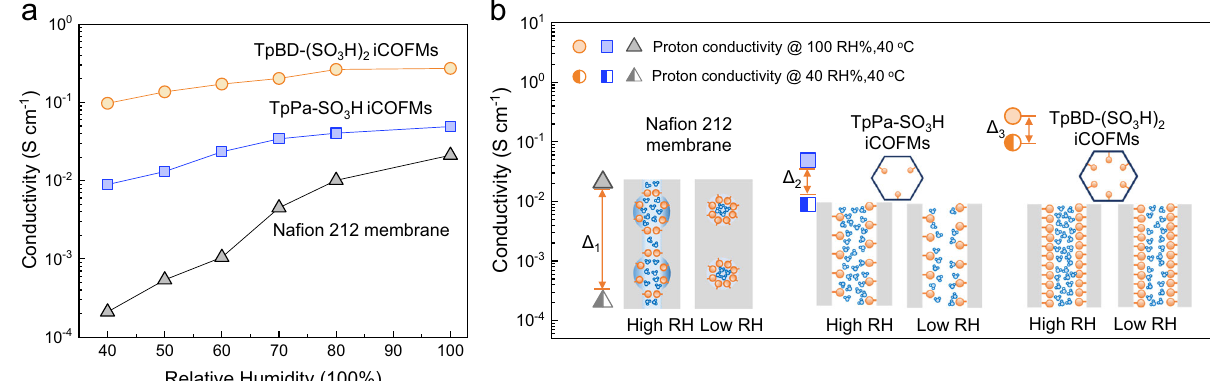
Fig. 5 Humidity – conductivity relationship of TpPa-SO 3 H, TpBD-(SO 3 H) 2 iCOFMs, and Na fi on 212 membrane. a Proton conductivity of the TpPa-SO 3 H, TpBD-(SO 3 H) 2 iCOFMs, and Na fi on 212 membrane versus relative humidity at 40 °C. b Schematic illustration of ion transport channels changes with decreased relative humidity (RH) for the Na fi on 212 membrane, TpPa-SO 3 H and TpBD-(SO 3 H) 2 iCOFMs, Δ represents the difference in the proton conductivity of the membranes at 100% RH and 40%